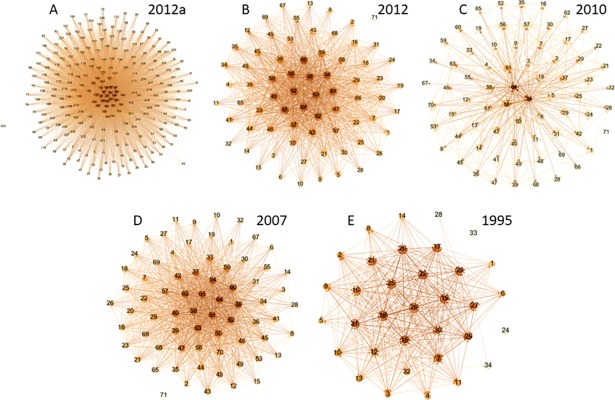
Network evolution of the input-output Ecuadorian matrix.(A) Detailed matrix 2012, 245 economic sectors. (B) Summary matrix 2012, 71 economic sectors. (C) Matrix 2010, 71 economic sectors. (D) Matrix 2007, 71 economic sectors. (E) Matrix 1995, 34 economic sectors. Each node represents a sector of the economy, and an edge has been mapped between two nodes when they have a percentage of trade equal to or greater than 1%.